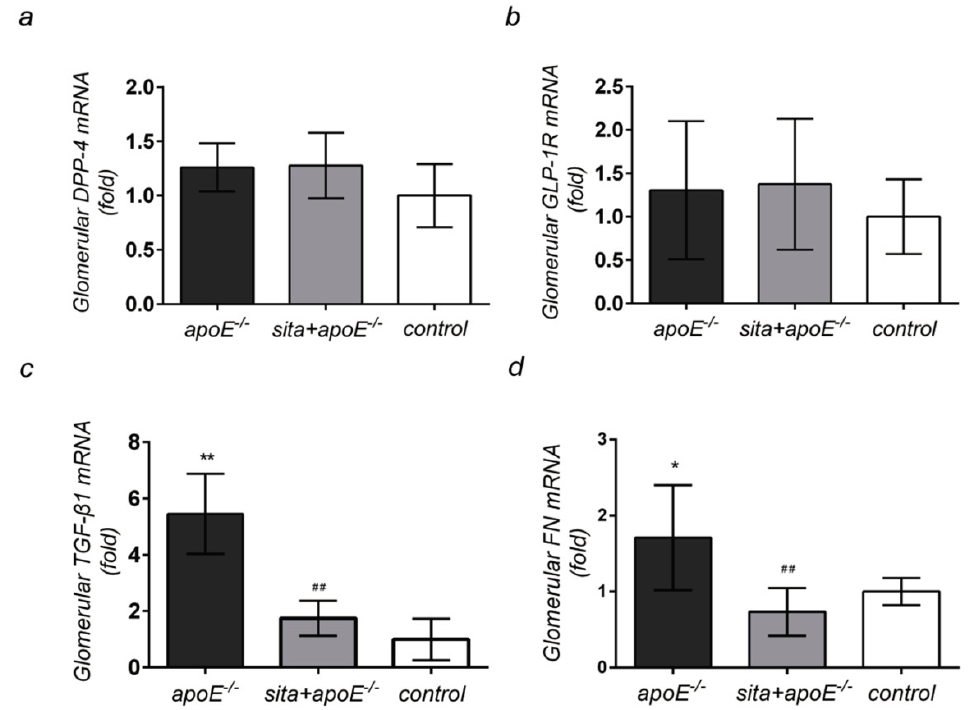
Figure 4. Effect of sitagliptin on renal cortical mRNA expression of DPP-4 , GLP-1R , TGF- β 1 and FN . Real time RT-PCR analysis was conducted on apoE − / − , sita + apoE − / − and control group at week 16 to examine ( a ) DPP-4 ; ( b ) GLP-1R ; ( c ) TGF- β 1 and ( d ) FN expression in renal glomeruli. Values are mean ± S.D. * p < 0.05 and ** p < 0.01 vs. control group; ## p < 0.01 vs. apoE − / −